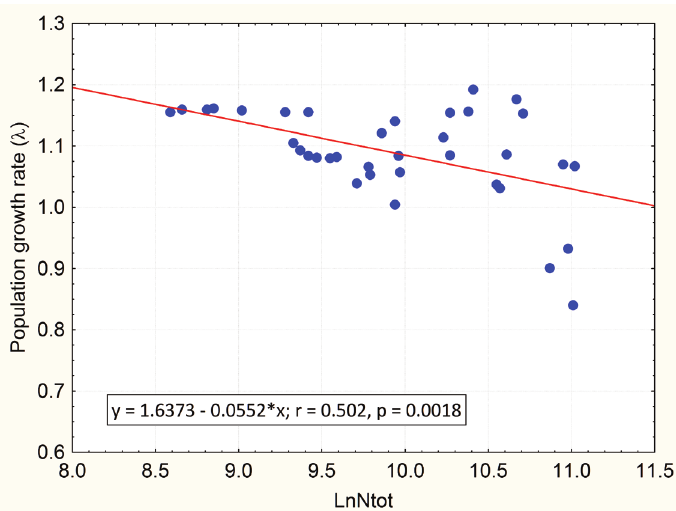
Figure 1. Effect of the guanaco population size on guanaco’s finite population growth rate ( λ ). On the x-axis the guanaco population from the Cameron ranch (Tierra del Fuego, Chile) was transformed to a natural logarithmic scale. The values of λ represent the finite population growth rate (on a per year time